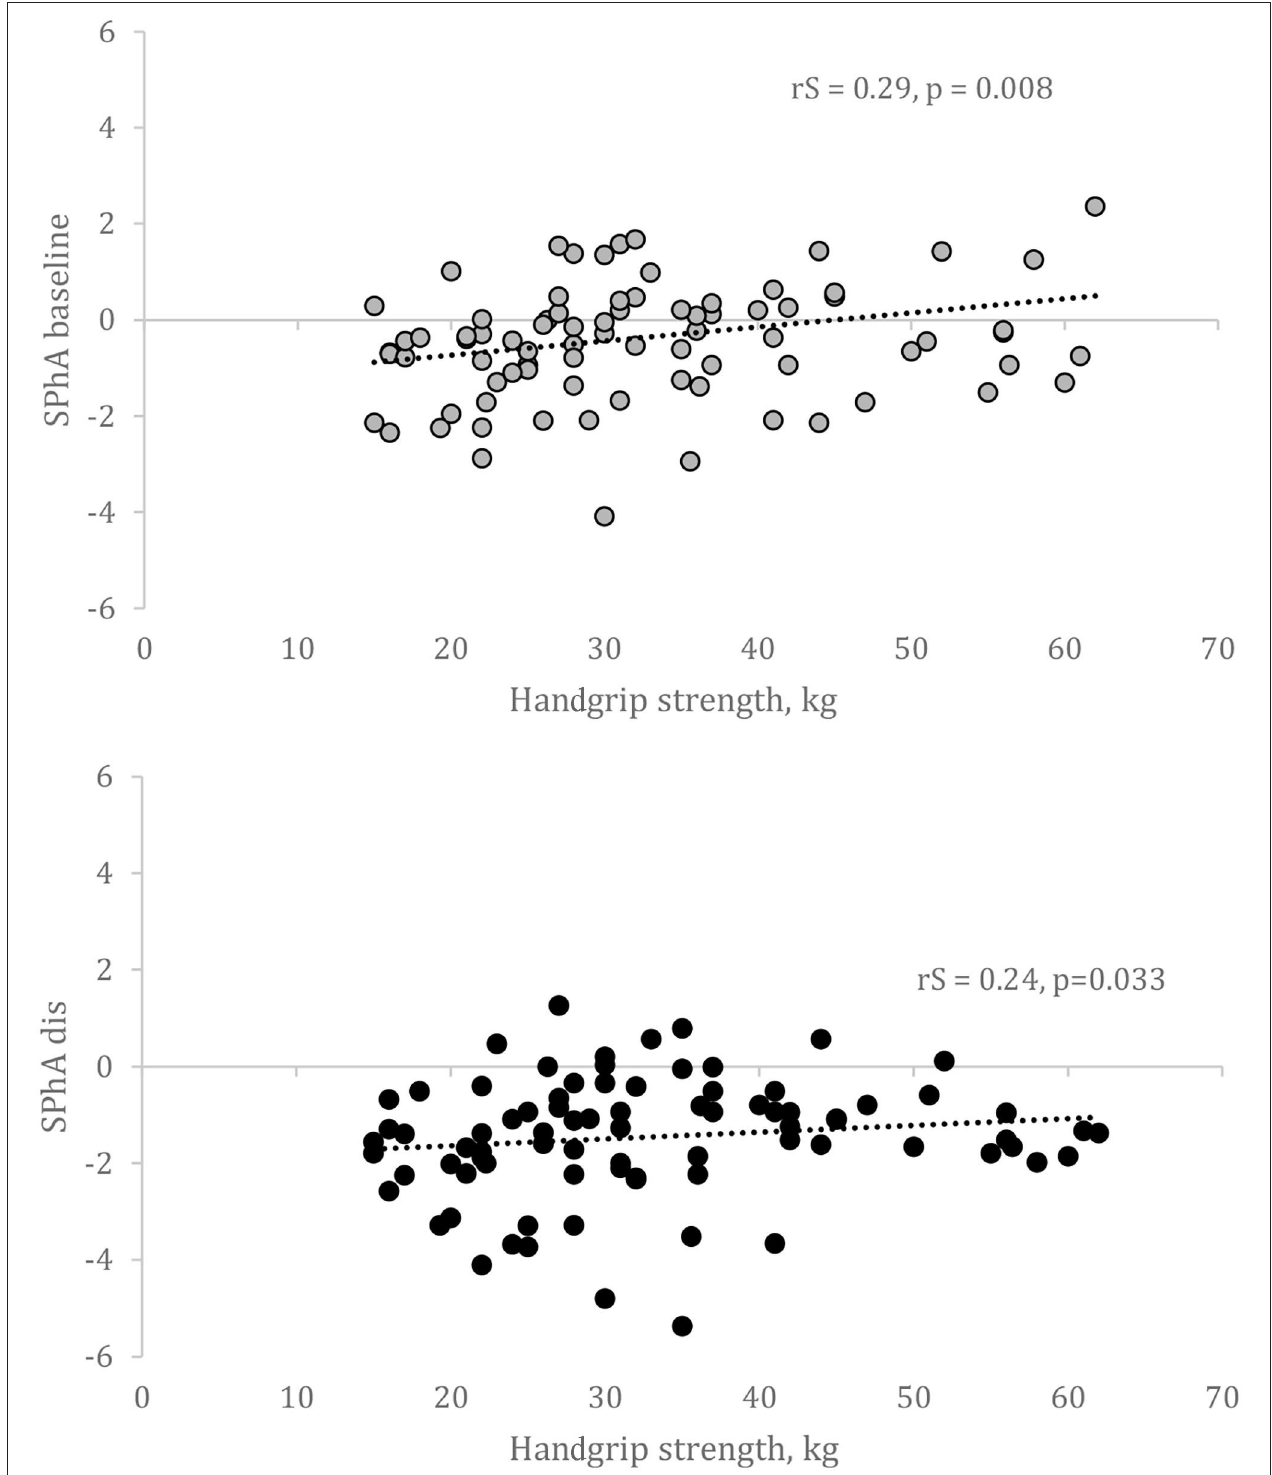
FIGURE 2 | Correlation between SPhA and HGS after 6 months after kidney transplantation. SPhA – standardized PhA. rS – Spearman’s correlation coefficient.